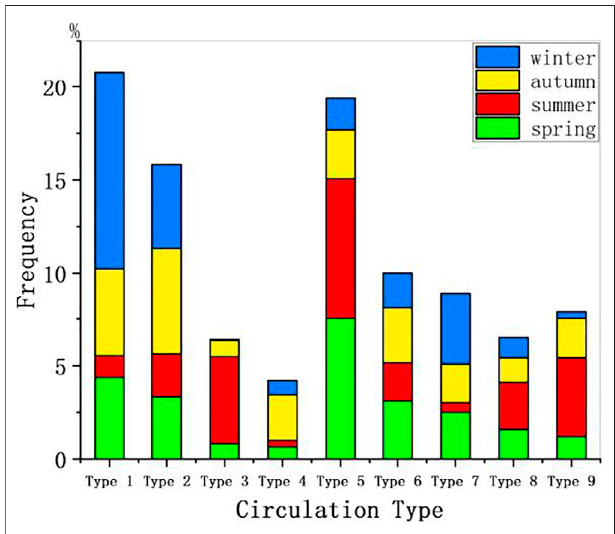
FIGURE 3 | Seasonal distribution of nine circulation patterns in Northeast China during 2016 –